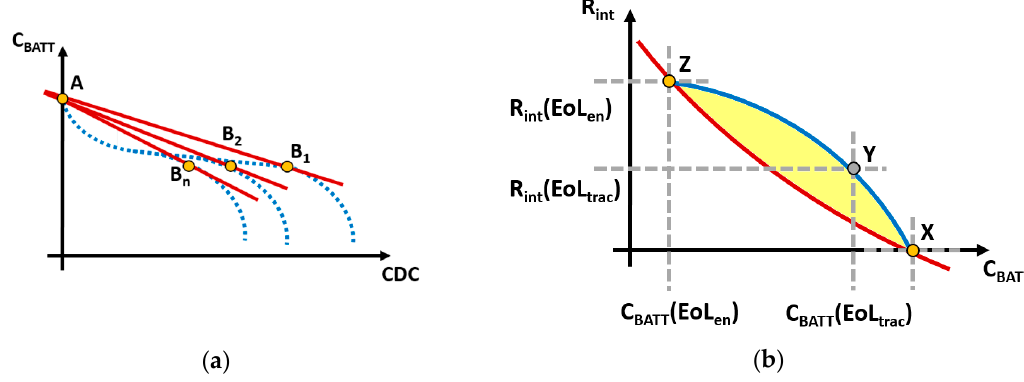
Figure 4. ( a ) Linear approximation—residual capacity vs. CDC for different DoD values; ( b ) Typical trend and approximation of the internal resistance vs. residual capacity trend and approximation of the internal resistance vs. residual capacity relationship.